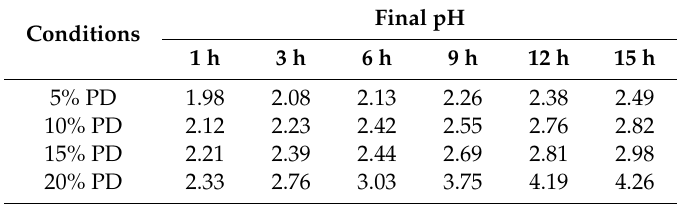
Table 4. Initial and final pH of slurry with 2 N citric acid in varying pulp densities of slag at 308 K. Conditions